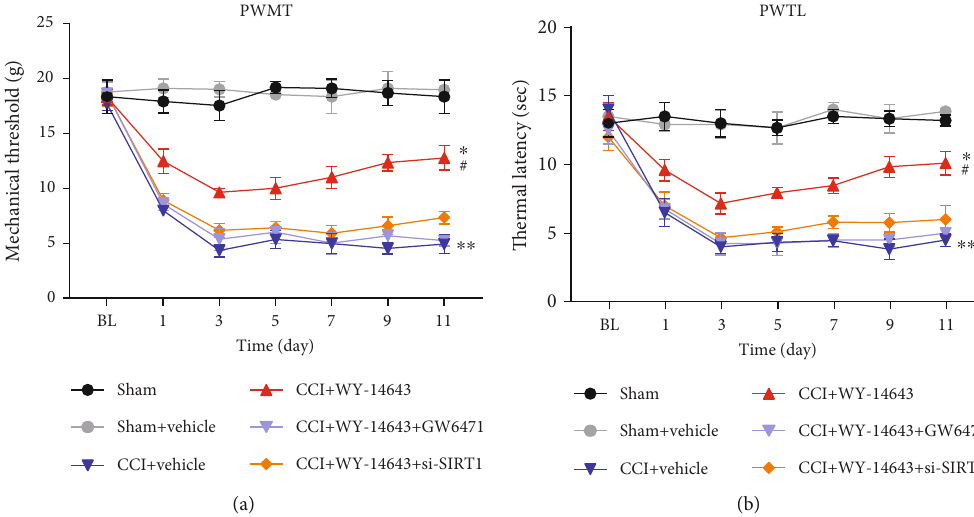
Figure 2: Repeated WY-14643 administration alleviated NP in CCI rats by activating PPAR α . (a) WY-14643 increased the PWMT of CCI rats, but GW6471 and si-SIRT1 reversed this e ff ect. (b) WY-14643 increased the PWTL of CCI rats, but GW6471 and si-SIRT1 reversed this e ff